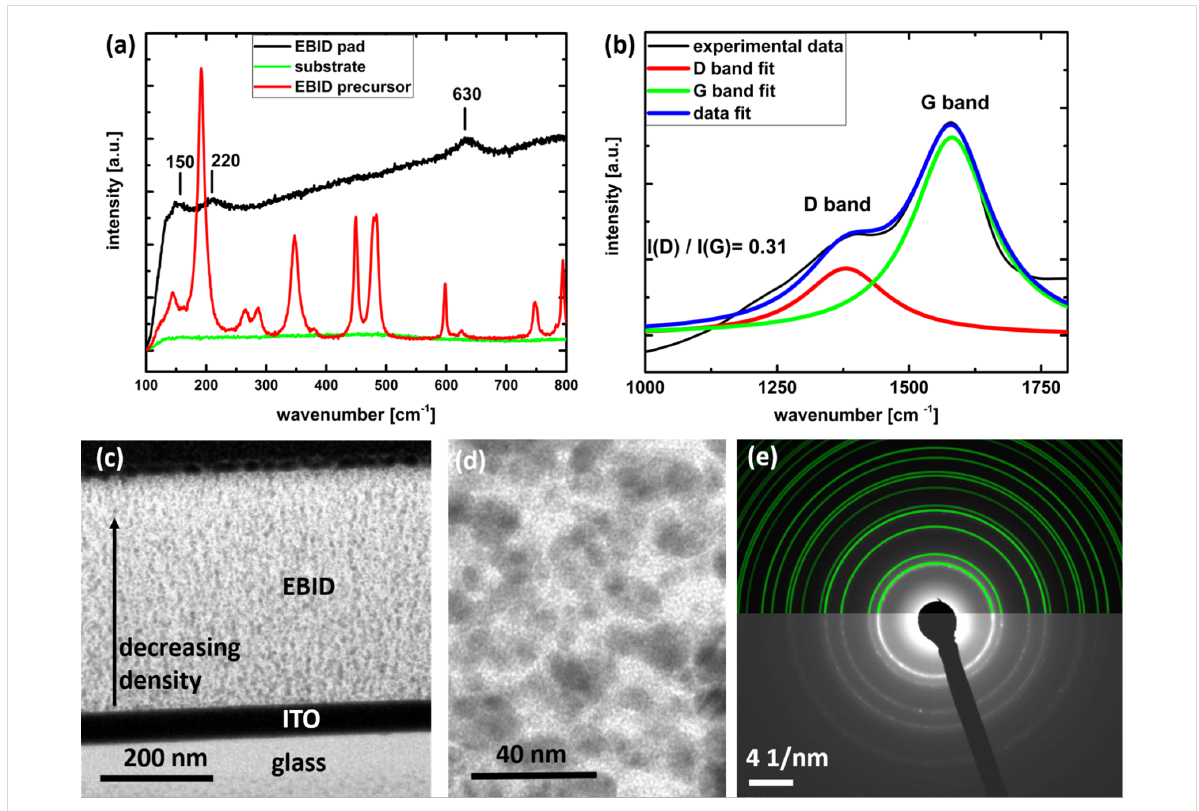
Figure 2: (a) Raman spectra of a FEBID pad, FEBID precursor and the substrate. The complex structure of the precursor leads to a variety of spec- tral features. Indicated are three Raman lines for Cu 2 O [17] corresponding well with the ones measured in the FEBID pads. (b) Raman features of the amorphous carbon matrix in the FEBID material. (c) Cross-section TEM image of a FEBID pad. (d) High-magnification TEM of FEBID pad. (e) SAED indexing of copper particles in the FEBID material, with all diffraction rings corresponding to indicated green Cu diffraction